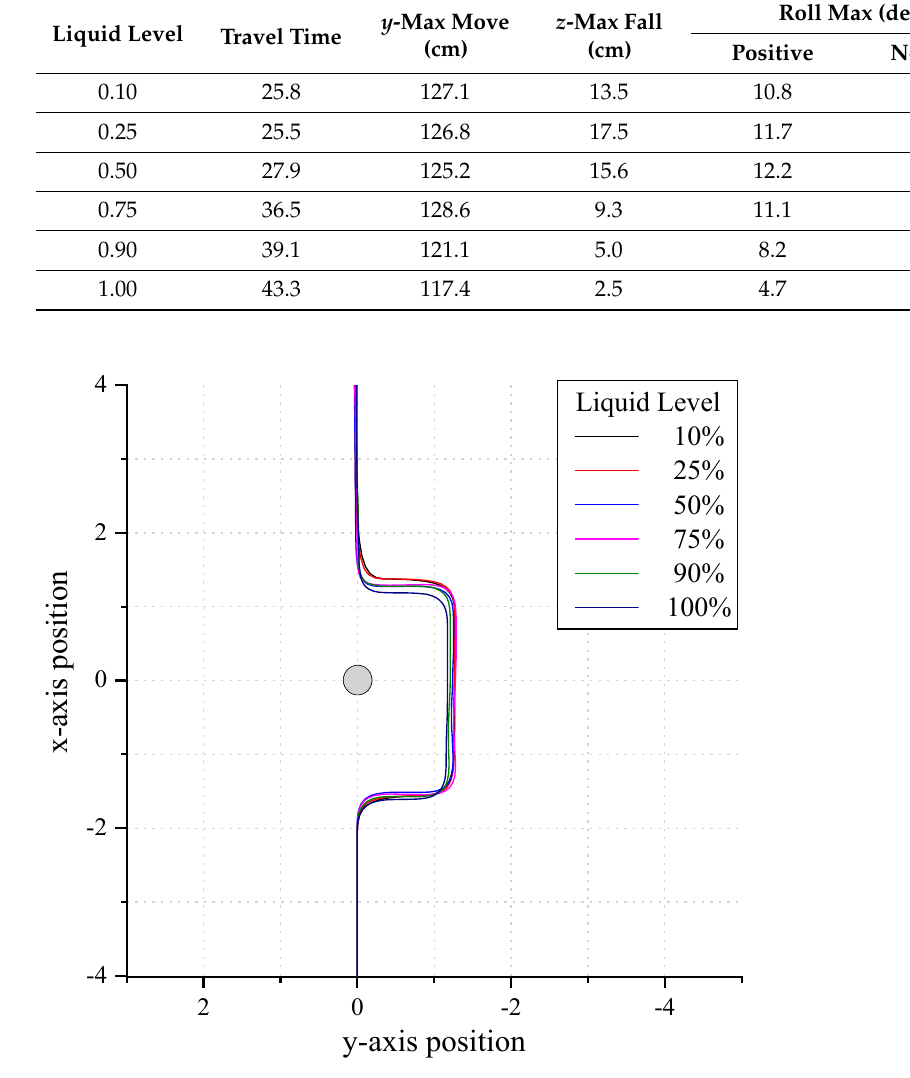
Figure 12. Different flight positions of UAVs carrying different liquid levels.